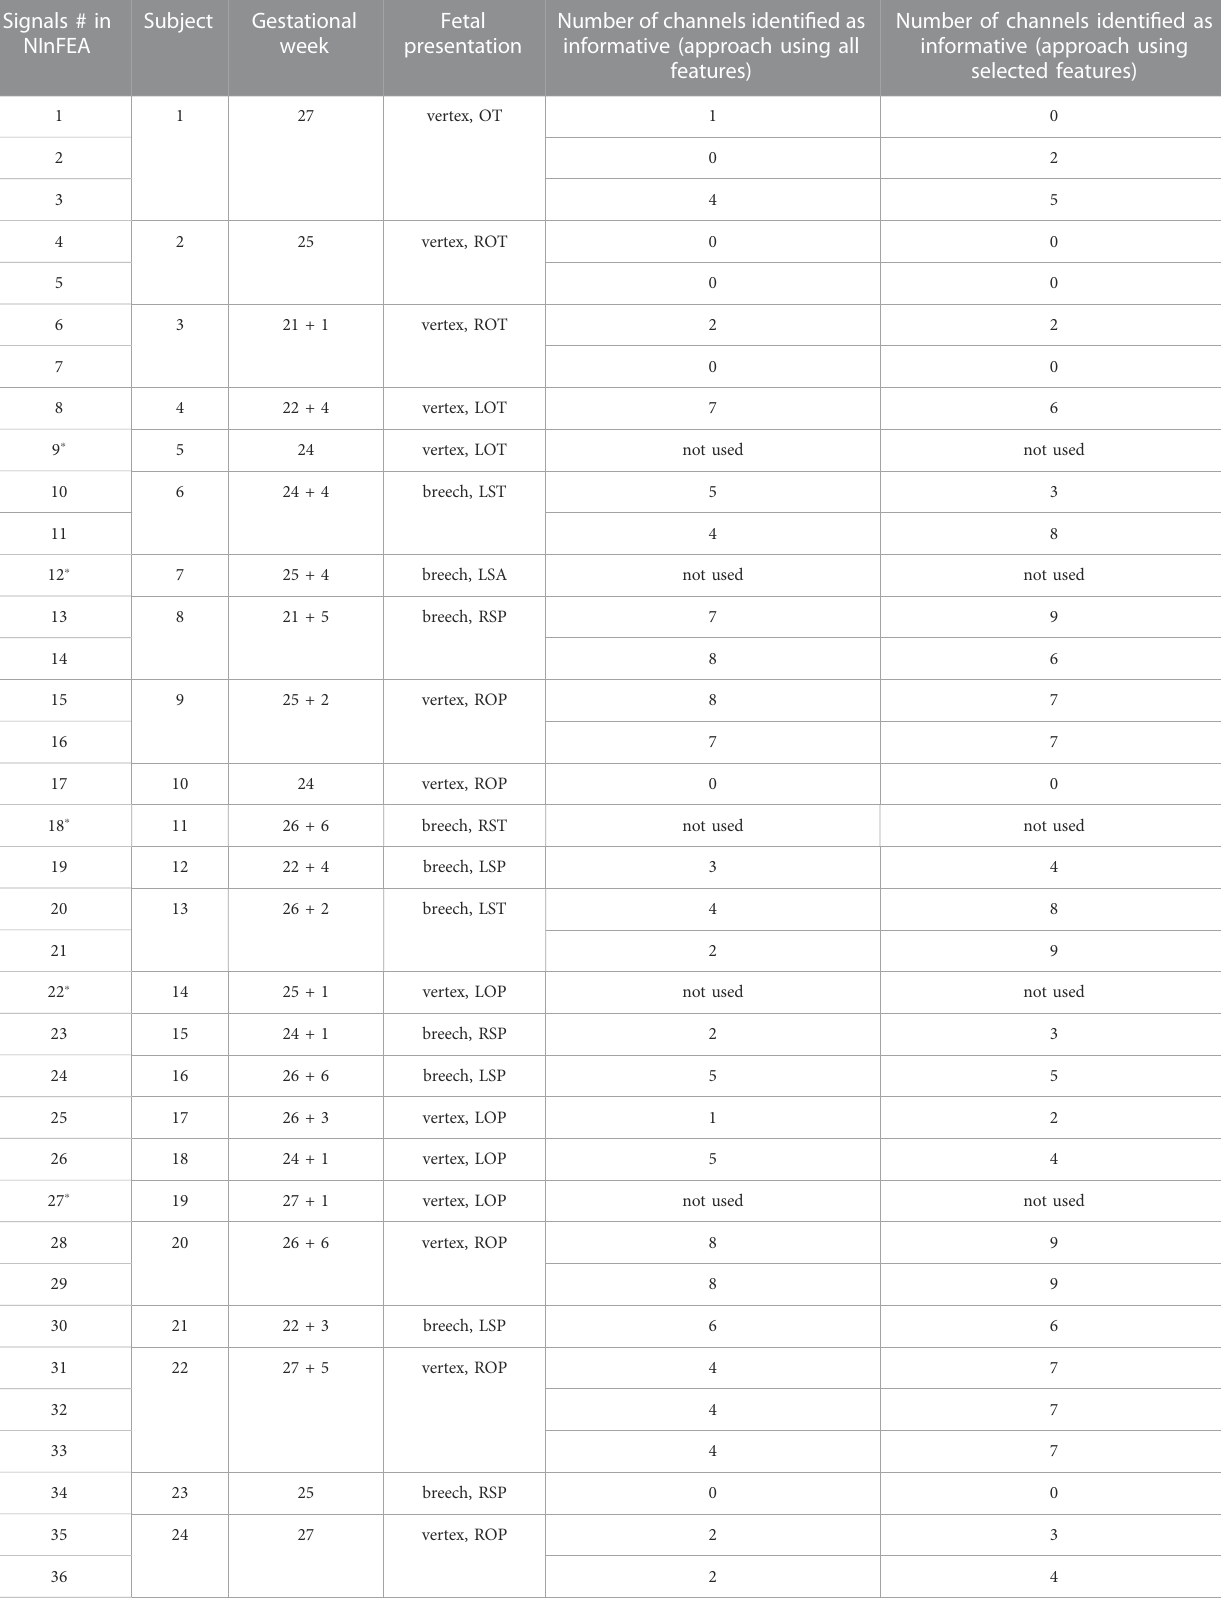
TABLE 2 Number of raw abdominal channels identi fi ed as informative by the proposed approach exploiting all features or selected features only, with the clinical information about the week of gestation and the fetal presentation of the recordings (L: left, R: right, O: occiput, S: sacrum, T: transverse, P: posterior A: anterior). Datainformationfortheadopted50recordingswastakenfromSulasetal.(2021).Amongthesignals,someofthemwerenotusedbecauseofunreliablefetalQRS annotation (marked with *) or because of too short duration (marked with ‡ ). Signals # in Subject Gestational Fetal Number of channels identi fi ed as Number of channels identi fi ed as NInFEA week presentation informative (approach using all informative (approach using features) selected